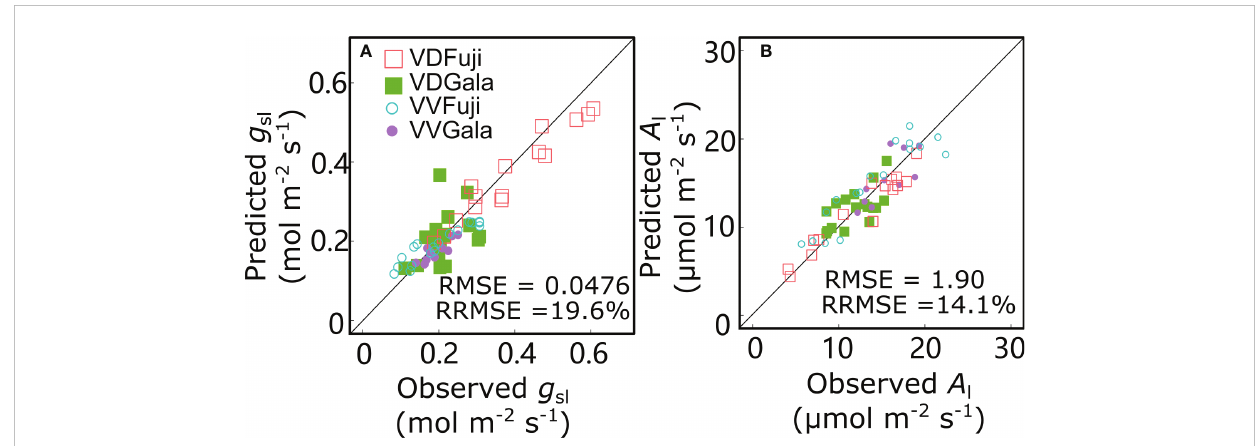
FIGURE 7 Relationships between observed and predicted stomatal conductance ( g sl ) (A) and net photosynthesis rate ( A l ) (B) for ‘ Fuji ’ and ‘ Gala ’ apple trees grafted on vigorous rootstocks associated with either a dwarf M26 interstock (VD) or a vigorous ‘ Qinguan ’ interstock (VV). Each point represents one measurement/simulation at the leaf level. The 1:1 lines are represented.